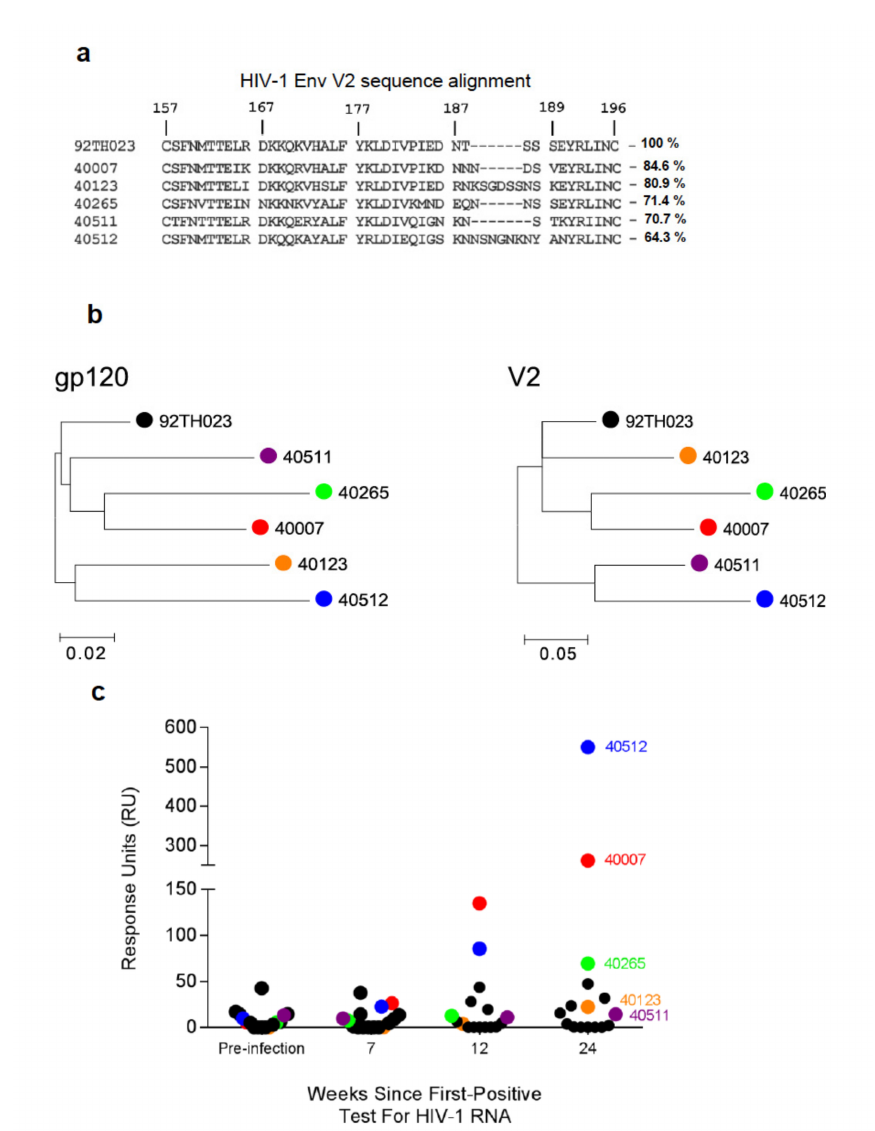
Figure 1. V2-specific antibody responses in the plasma of RV217 Thai cohort participants. ( a ) Sequence alignment of the V2 region for 92TH023 (clade A / E) and CRF01_AE (clade A / E) transmitted founder virus (T / F) sequences derived from five RV217 participants (40007, 40123, 40265, 40511, and 40512) one-week post-infection (HXBc2 numbering is shown for reference). Percentage sequence identity of T / F V2 region amino acid sequence to 92TH023 is indicated to the right of the RV217 V2 sequences. ( b ) Maximum Likelihood (ML) trees showing the phylogenetic relationship among selected RV217 participants. The trees were constructed using the general time reversible model for the participant’s gp120 (left) or V2 (right) sequences ( c ) Plasma binding responses specific to 92TH023 cyclic-V2 peptide were assessed by surface plasmon resonance (SPR-Biacore) for sixteen RV217 participants, prior to infection and at 7, 12, and 24 weeks following first positive test for HIV-1 RNA. Each circle represents the mean response units (RU) of four independent measurements of plasma samples diluted 1:100 for each of the 16 participants. Colored spheres indicate the five participants selected for further